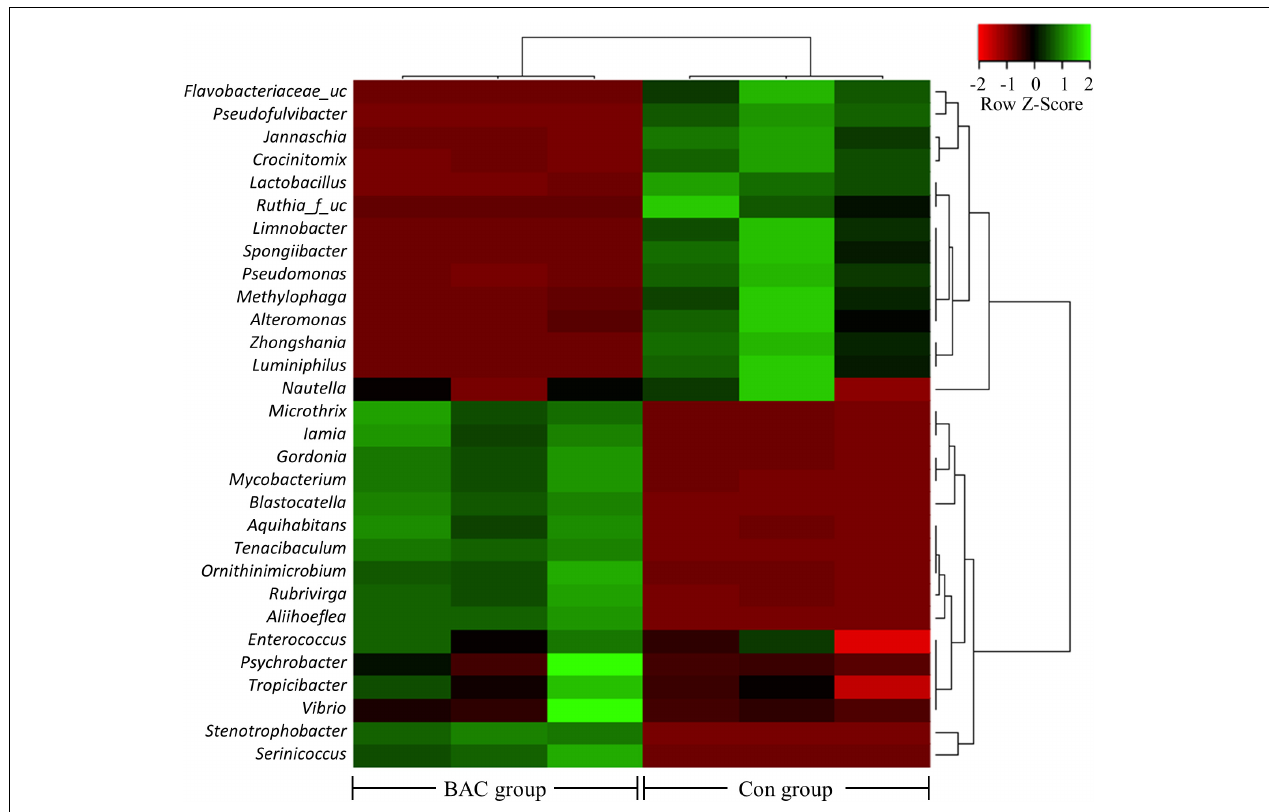
FIGURE 3 | Heatmap analysis of the genus abundance within the A. japonica microbiota from each group. Green represents the more abundant genus in the corresponding sample and red represents the less abundant genus.